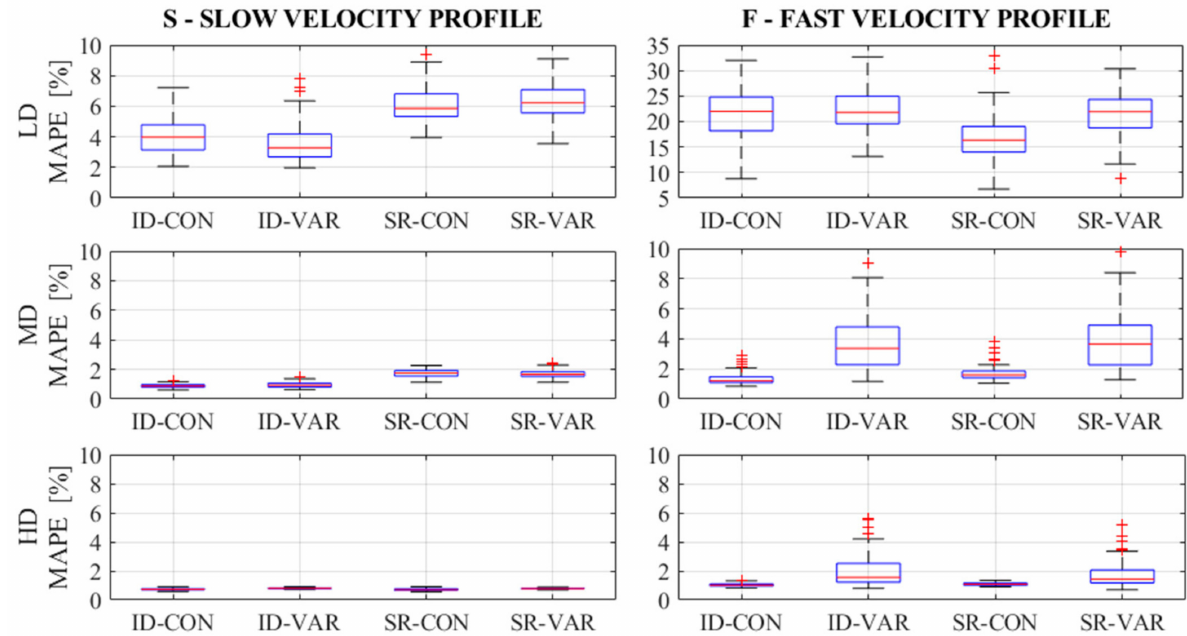
Figure 9. Boxplot of MAPE for all the scenarios of the first set of simulations (frame-rate = 4 fps, d = 30 s). Left graphs refer to the slow velocity case (S), while the right graphs to the fast (F) case. The low (LD), medium (MD), and high (HD) density scenarios are reported on the top, middle and bottom graph, respectively. In each graph, all the 4 possible environmental condition-tracer size schemes are reported: ID-CON ( ideal and constant size ), ID-VAR ( ideal and variable size ), SR-CON ( semi-real and constant size ), SR-VAR ( semi-real and constant size